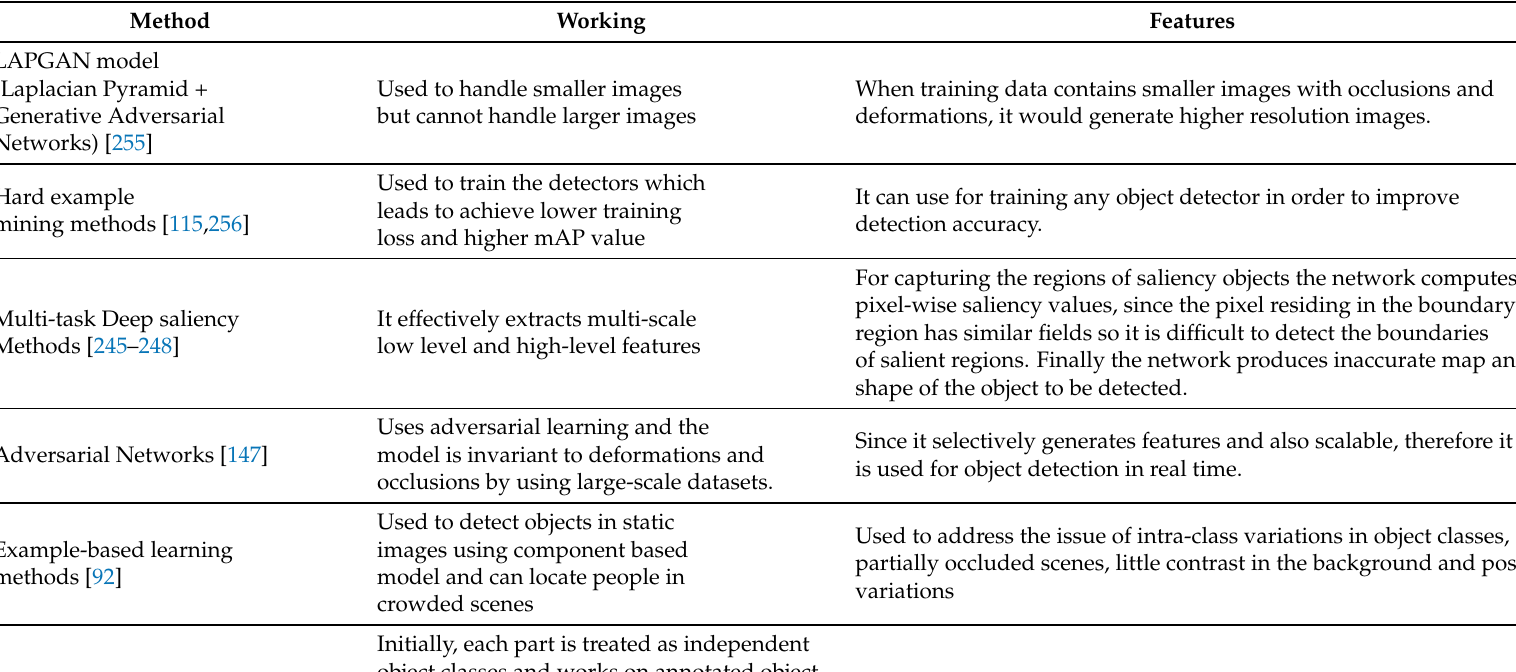
Figure out inter-class object variations at the finer level and works more only on certain object